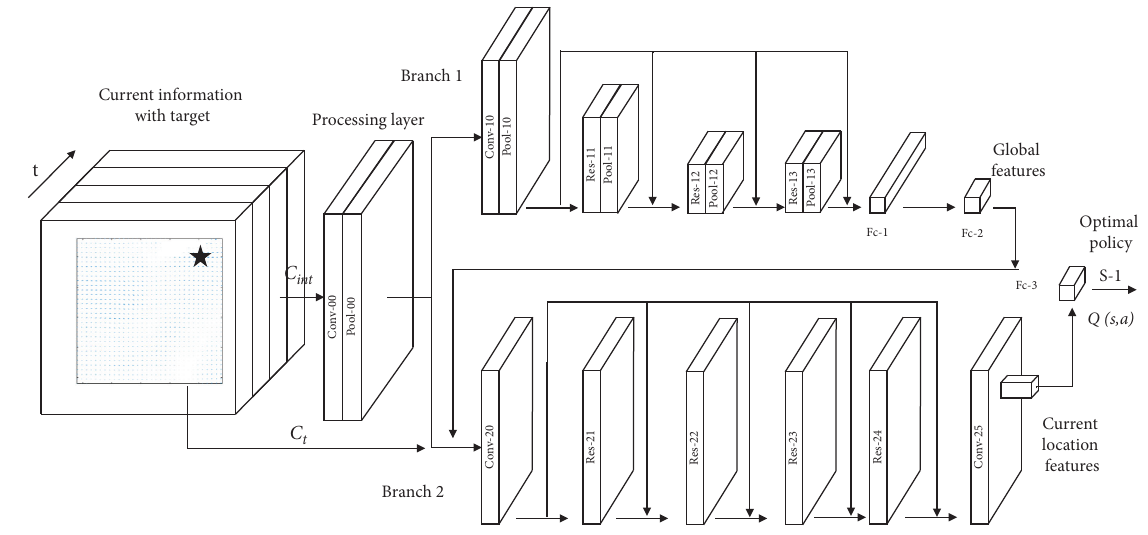
Figure 5: Doc-CNN for path planning.